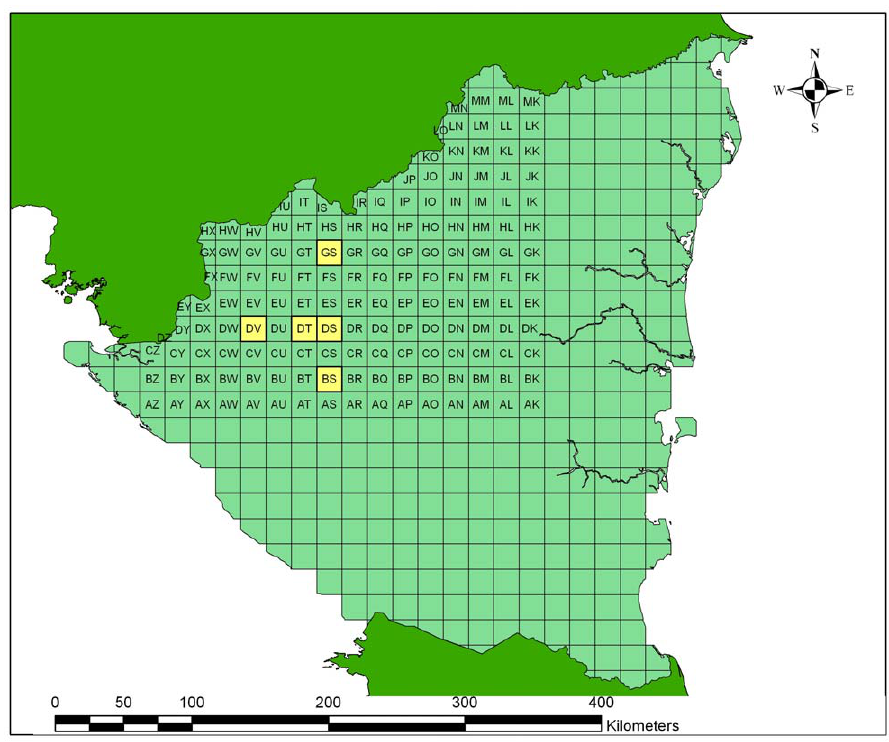
Figure 1. Two letter codes of each pixel used to identify the generated weather data.